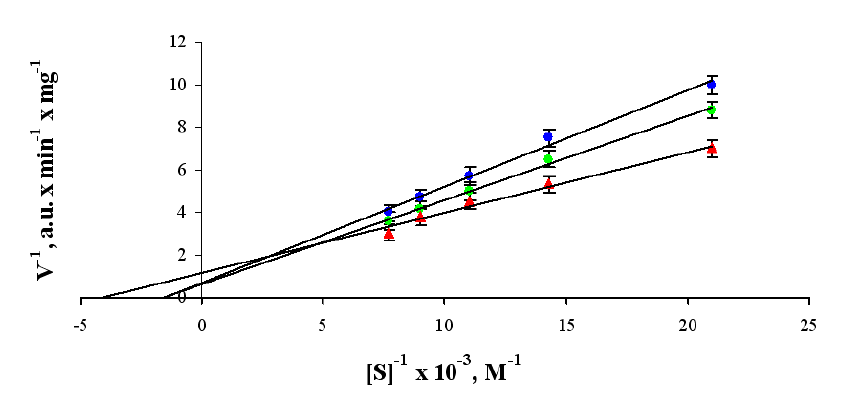
Fig. 2 Lineweaver-Burk plots (reciprocal initial rates of the enzymatic process vs. reciprocal substarte initial concentrations) for 3-CPBA decomposition in acetonitrile by catalase-based biocatalysts: CAT/TiS (red triangles; R= 0.991); CAT/NORIT (green circles; R= 0.998) and CAT/PM-100 (blue circles; R= 0.996). R denotes the linear regression coefficients for each